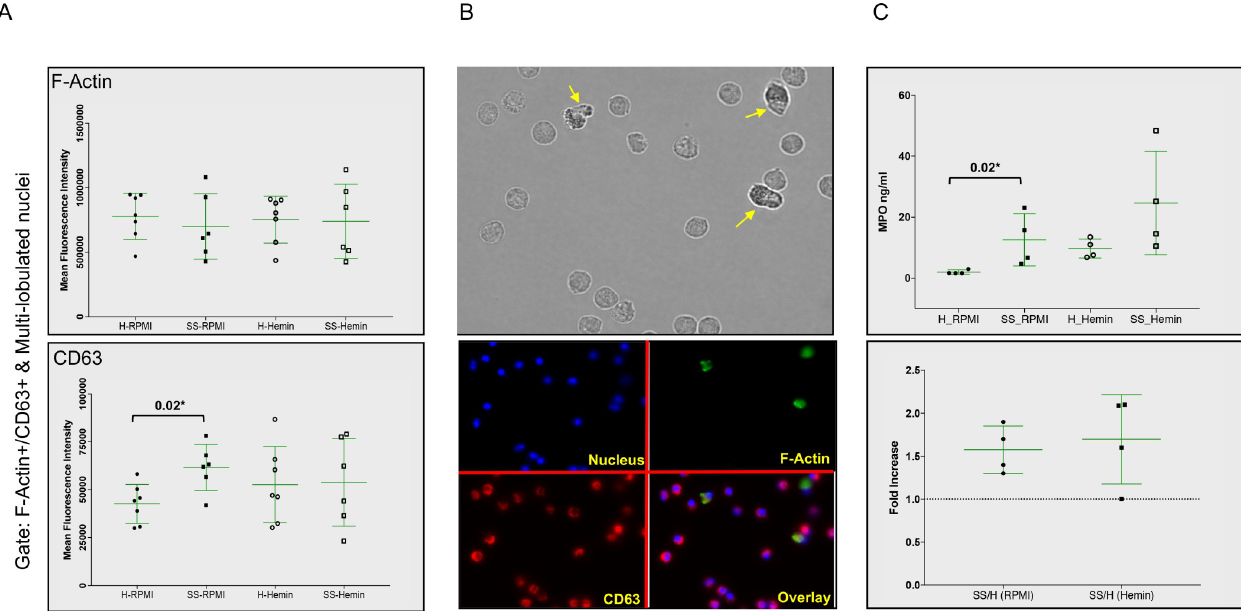
Fig 4. F-actin and CD63 co-localization associates with increased MPO release in SCD neutrophils. (A) Purified and rested neutrophils from healthy donors (H) and SCD patients in steady state (SS) were left untreated in RPMI as control or treated with 20 μ M hemin. Median Fluorescence Intensity of F-Actin (upper panel) and CD63 (lower panel) in F-Actin/CD63 double positive neutrophils with normal multi-lobulated nuclei is shown. (Healthy N = 7; SCD N = 6). (B) Z-stack stills of SCD neutrophils left in RPMI for 30 minutes showing neutrophils with roughed cell membranes (yellow arrows, upper panel). Staining for DNA (blue), F-Actin (green) and CD63 (red) is presented (lower panel). (C) MPO release was assayed by ELISA following 30 minutes incubation with or without the hemin stimulus (H (Healthy) N = 4; SS (SCD) N = 4). Degranulation response was assayed in terms of MPO ng/ml plasma (upper panel), or fold increase over healthy neutrophils (lower panel). Data presented as dot plots ± S.D., significance calculated with an unpaired Mann- Whitney test.